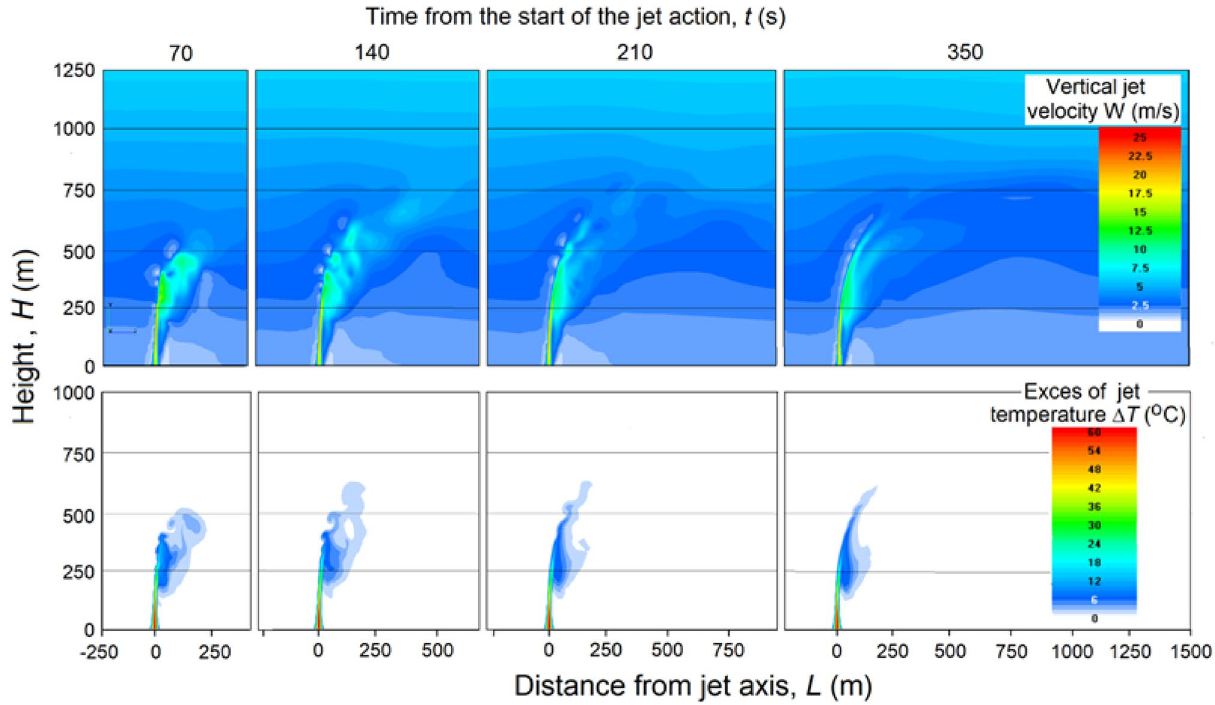
Figure 11. Vertical sections of W and Δ T fields with wind speed profile U = 1 + 0.004 H , γ = 6.5 °C/km, f = 45%.